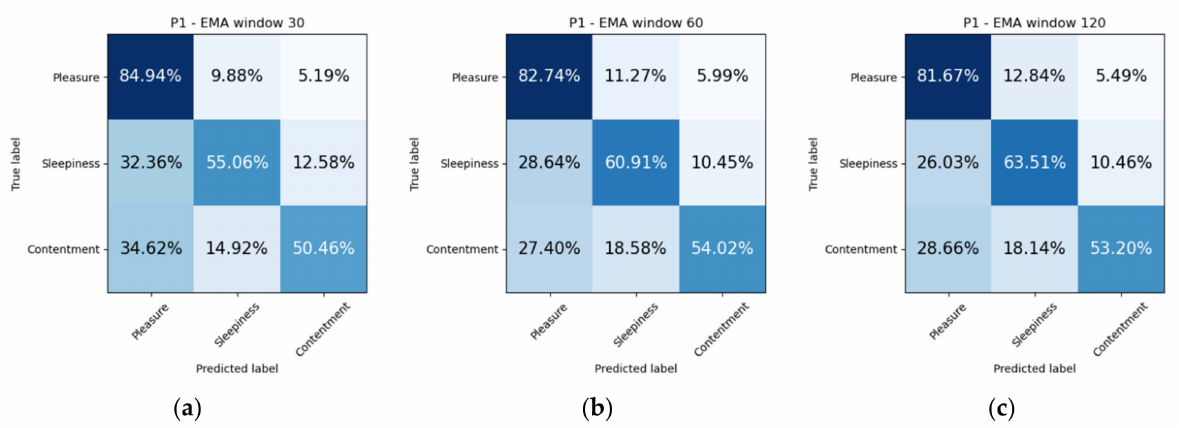
Figure 12. Confusion matrix for patient P1 for windows ( a ) 30-, ( b ) 60-, ( c ) 120-min. Predicted mood states: Pleasure, Sleepiness and